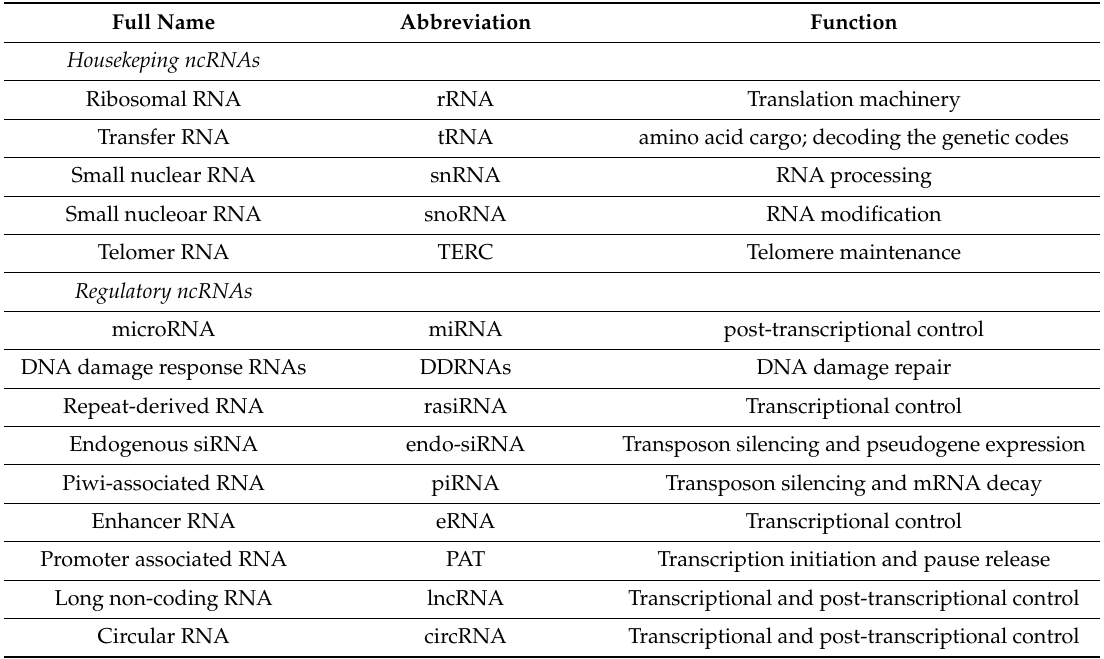
Table 1. List of housekeeping and regulatory non-coding RNAs (ncRNAs) together with the corresponding abbreviation and